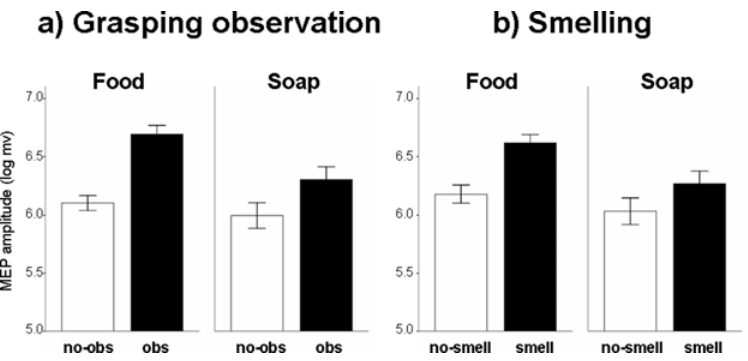
Figure 4. Results of Experiment 2 (Food vs Soap). Graphical representations of the main significant interactions: a) an higher MEP increase occurred when the subjects observed a grasping movement toward a food object than toward a non-food object; b) an higher MEP increase occurred when the subjects smelled a food object than a non-food object